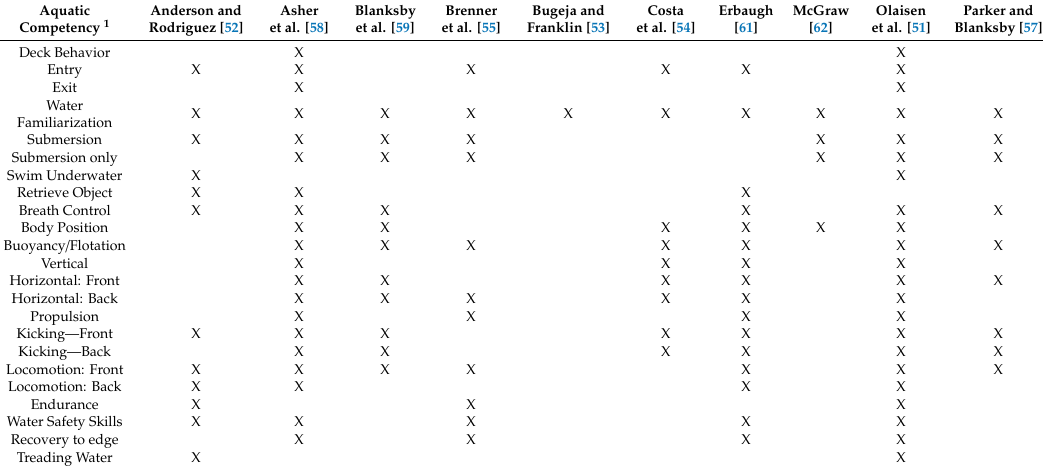
1 Complete list of water competencies can be found in Table